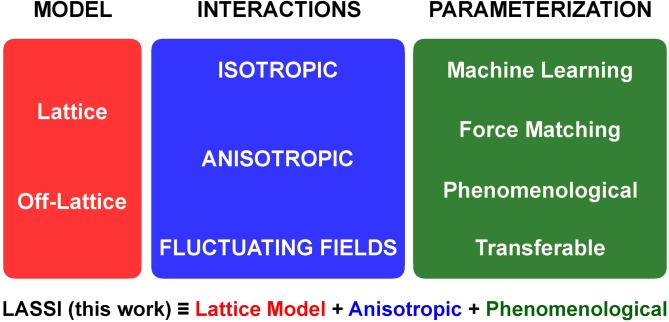
Considerations that go into designing a coarse-grained model.As discussed in the text, the choice of a coarse-grained model has at least three ingredients. These include the type of conformational space (lattice or off-lattice), the nature of the interactions among entities that are represented in the coarse-grained description (isotropic, anisotropic or fluctuating fields), and the parameterization approach. LASSI, as described here, is based on a lattice model that uses anisotropic interactions and a phenomenological model.